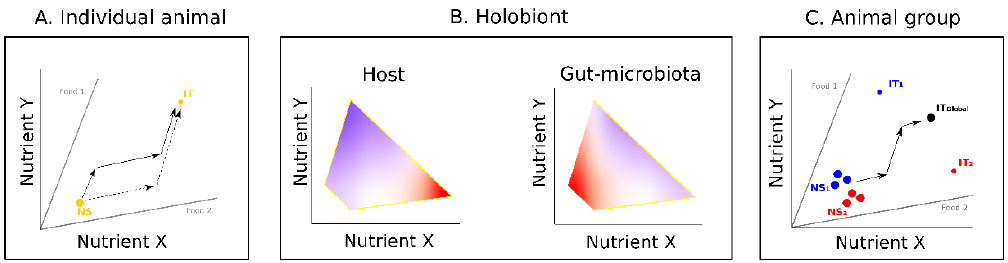
Figure 1. Nutritional geometry models for individual animals, holobionts, and animal groups. ( A ) Model for a hypothetical animal (modified from [25]). The nutrient space is defined by two nutrients. Nutritional rails (grey lines) represent the ratio of nutrients X and Y in two foods. Yellow dots represent the nutritional state (NS) and the intake target (IT) of the animal. In this example, foods 1 and 2 are individually imbalanced (ratio different from the animal’s IT) but collectively complementary (fall in opposite sides of the animal’s IT): The animal can reach its IT by combining its intake from the two foods. Sequences of arrows show two possible strategies. ( B ) Model for a hypothetical holobiont (modified from [26]). The performance responses of holobiont components (host and gut microbes) to nutrient intake are shown in separate heatmap landscapes. The strength of response of each holobiont component is indicated by a color code (warmer colors show strongest responses). In this example, changes in nutrient intake have different influences on the fitness of the host (maximum for high X low Y intake) and the gut microbiota (maximum for low X low Y intake) indicating the potential for a conflict in food requirements. ( C ) Model for a hypothetical group of animals (modified from [28]). The group is composed of two sub-groups of highly interacting individuals (blue and red circles). In this example, each individual has its own NS but individuals of the same sub-group have the same IT (sub-group 1: IT 1 ; sub-group 2: IT 2 ). All individuals are socially attracted and feed together on the same foods. Animals must trade-off between choosing food to address their own nutritional needs and following others. This can be achieved by collectively reaching a group-level intake target (IT global) midway between the two sub-group ITs.